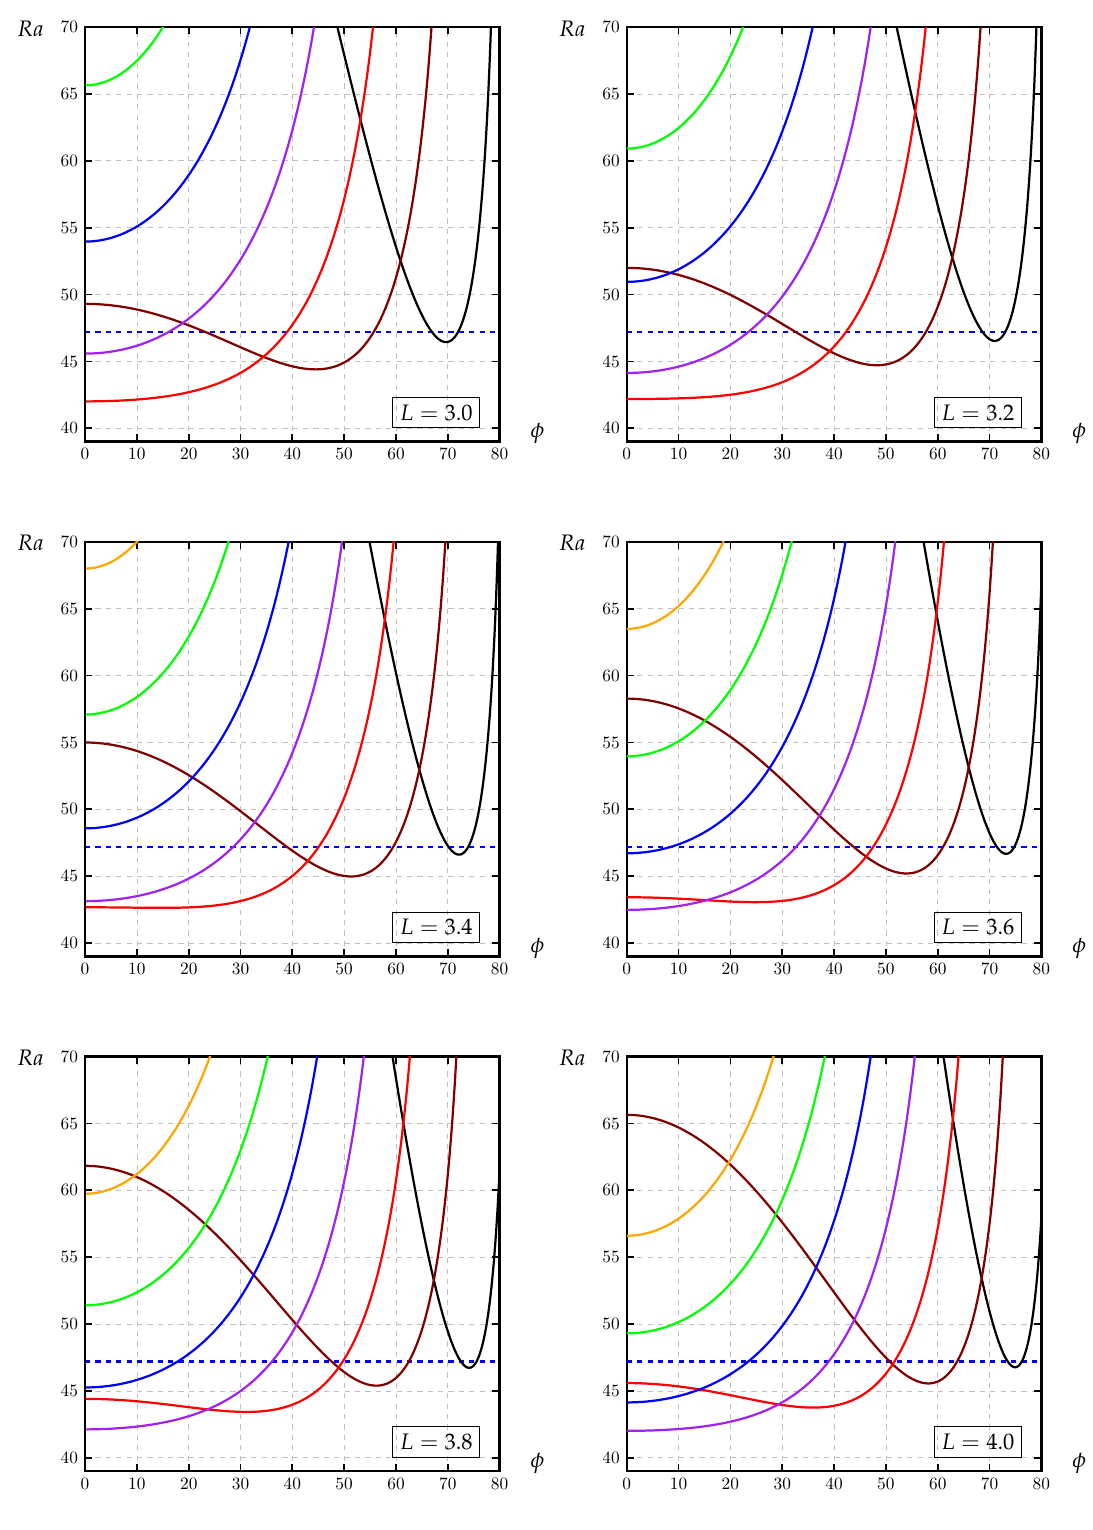
Figure 3. Critical values of Ra against φ for α = 20 ◦ and for the given values of L . The following modes are shown: n = 1, n = 2, n = 3, n = 4, n = 5, n = 6 and n = 7. The horizontal line corresponds to transverse